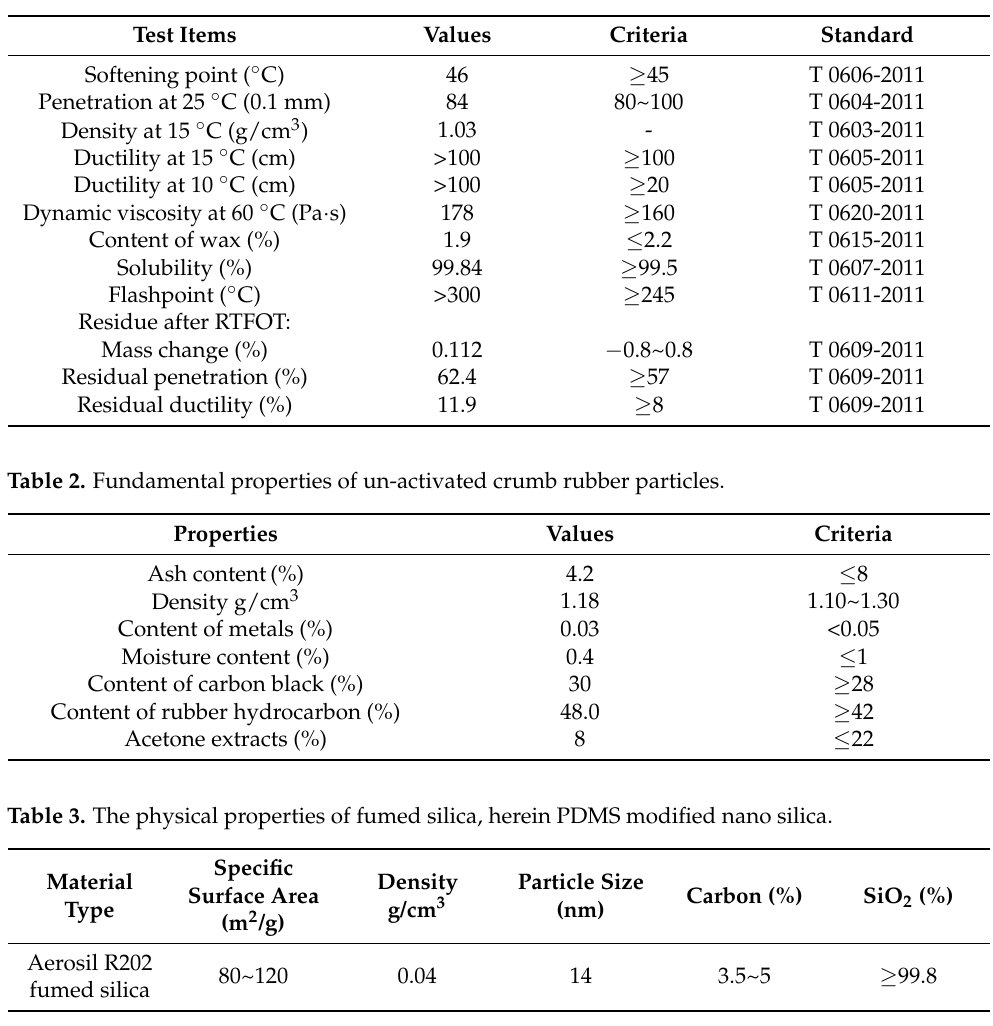
Table 1. Fundamental properties of bitumen penetration grade 80–100.